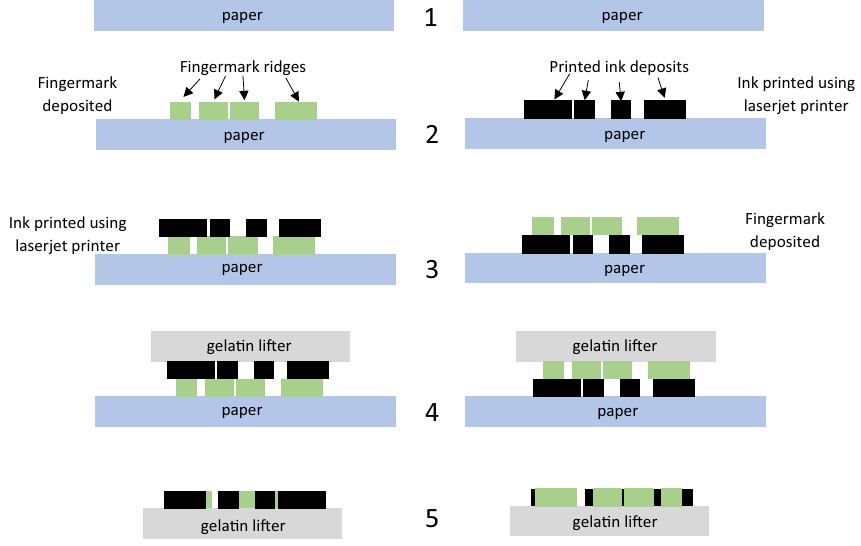
Figure 6. A cross sectional schematic showing the sequence of fingermark placement and printing prior to gelatin